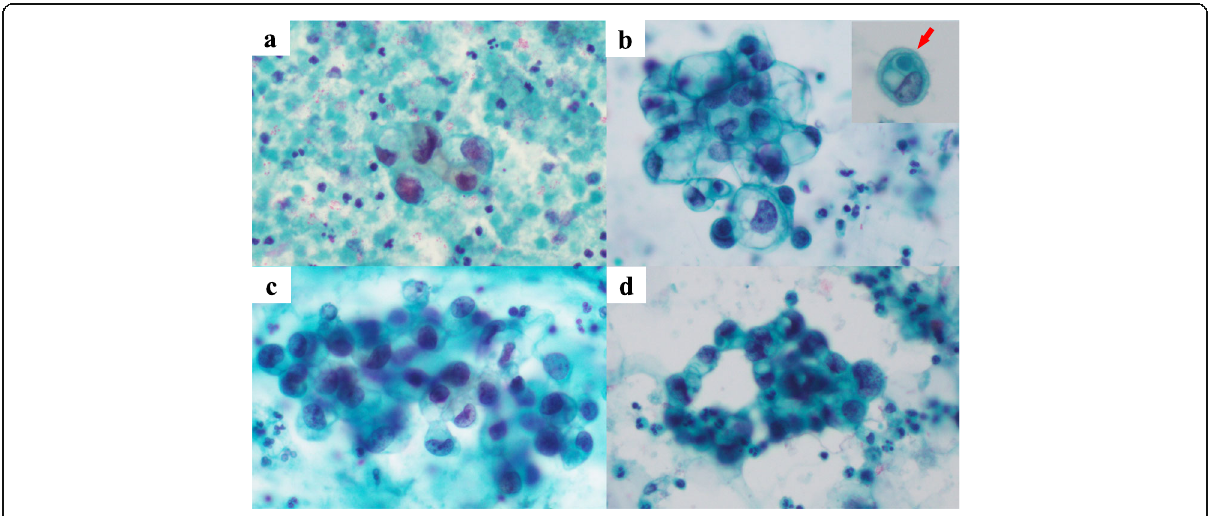
Fig. 2 Cytological findings. A small number of degenerative atypical cells with enlarged and irregular nuclei in the hemorrhagic and inflamed background ( a : left nephrostomy urine). Atypical cell clusters with focal clear cytoplasm. The inset indicates a representative type A intracytoplasmic lumen with a secretory globule (arrow) ( b : left renal cyst fluid). Slightly large clusters of degenerative atypical cells ( c : catheterized bladder urine). Overtly atypical cell clusters with high N/C ratios ( d : bladder washings) (All photos; Papanicolaou staining, × 40)